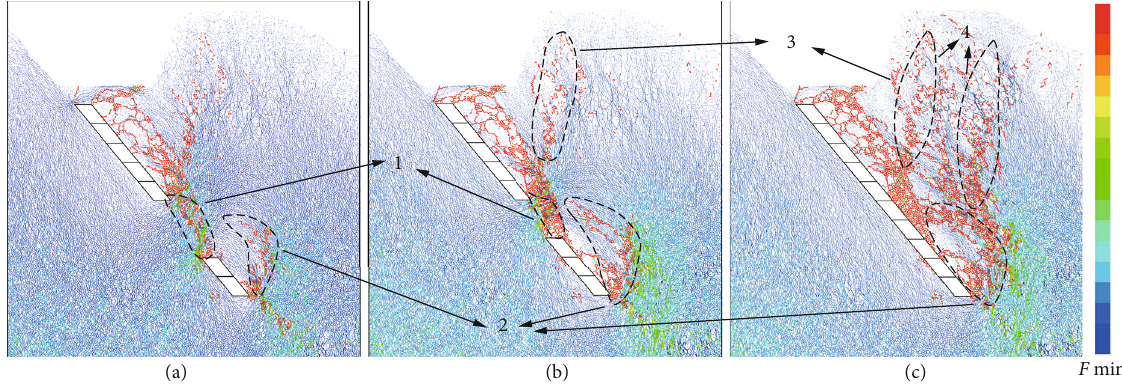
Figure 15: Mesoscale force fi eld distribution and crack propagation during the seventh, eighth, and tenth excavation steps.